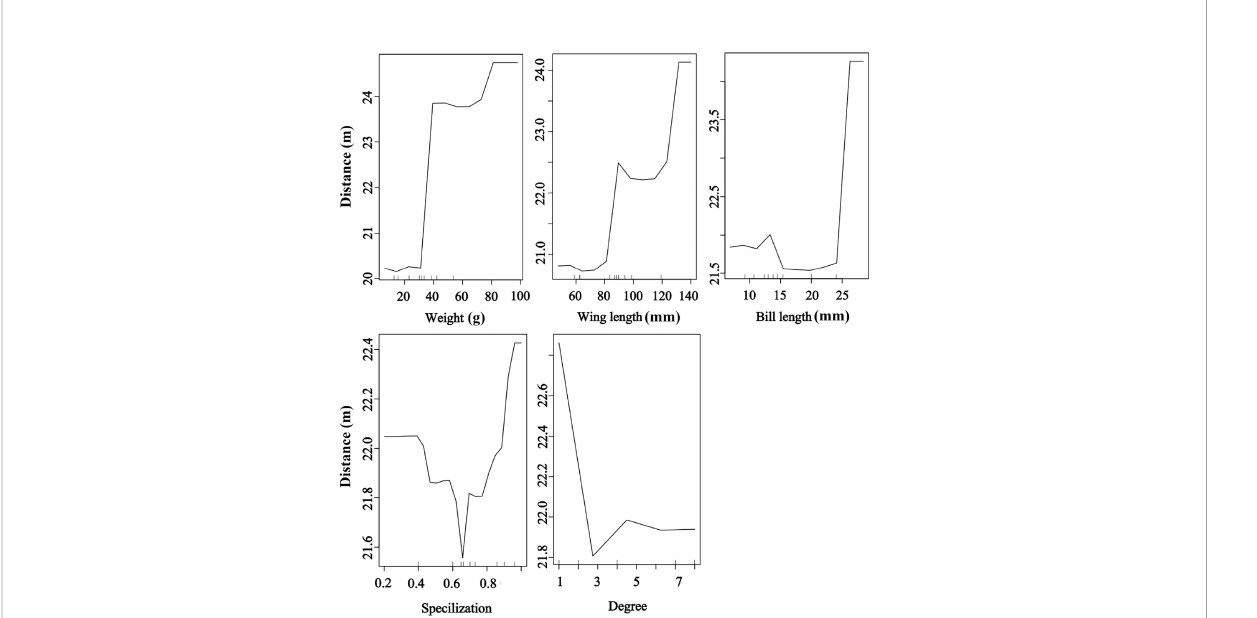
FIGURE 6 Effects of bird traits and two network metrics on the dispersal distance representing a fragmented forest in Southeast China. Results were determined using the Random Forest algorithm and showed the partial effects of independent variables on dispersal distance.